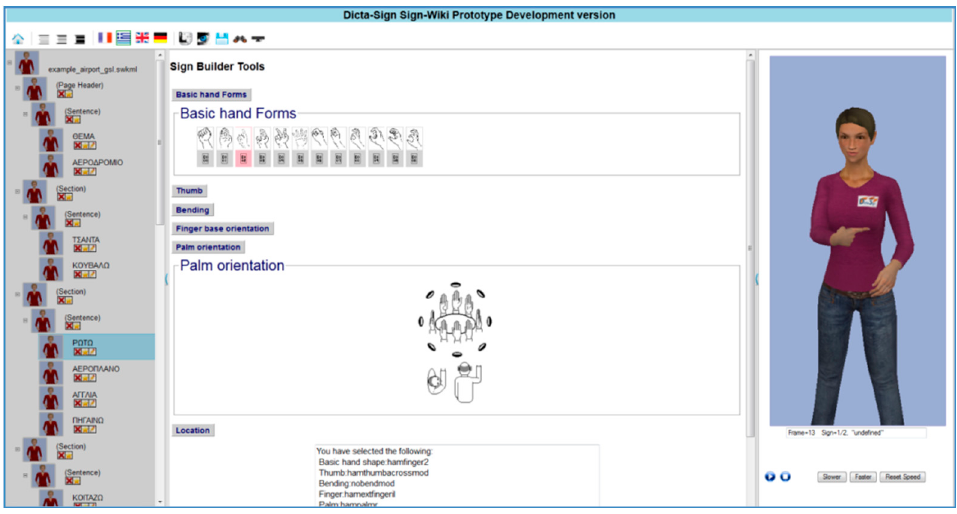
Figure 1. Building and representation signs in the Dicta-Sign demonstrator.